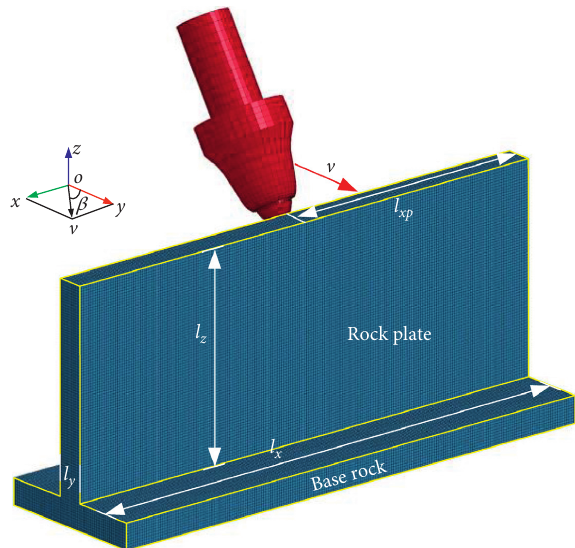
Figure 4: The finite element model of rock plate